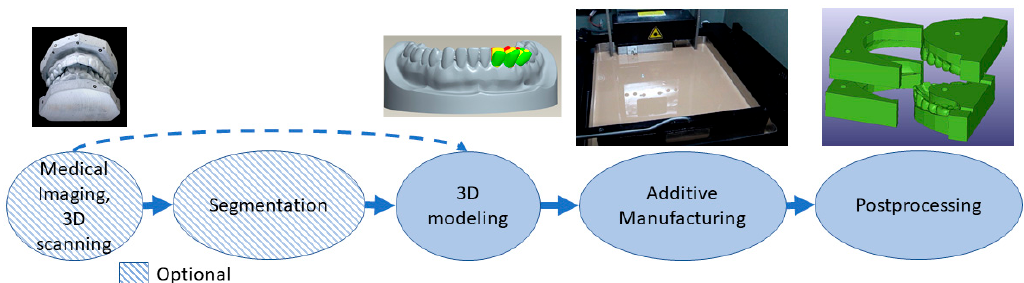
Figure 4. Typical process flow for tools, instruments and parts for medical devices.